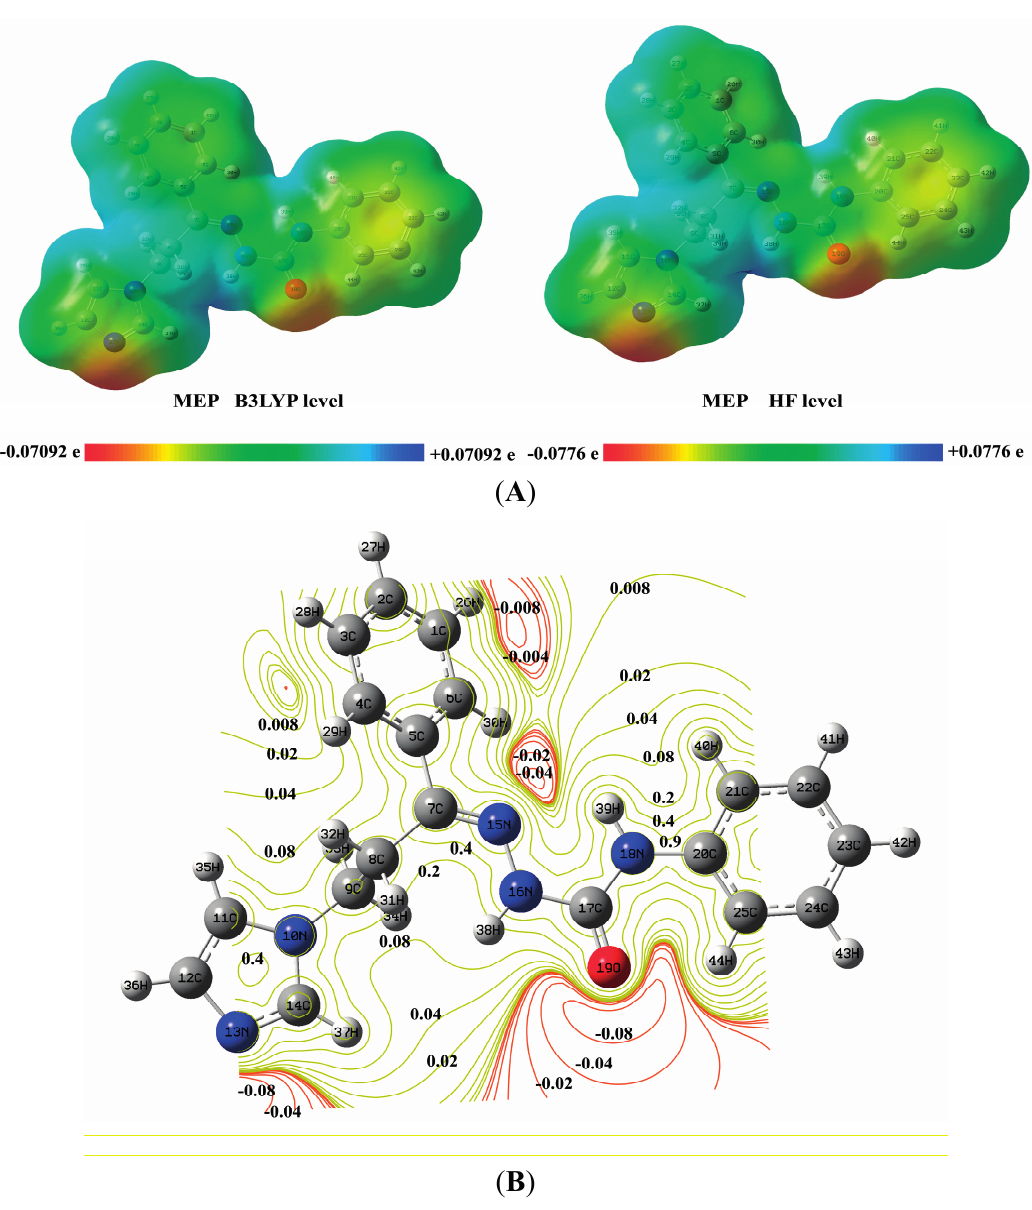
Figure 6. A representative illustration of the molecular electrostatic potentials (MEPs) ( A ) and contour map of (2 E )-HIPC ( B